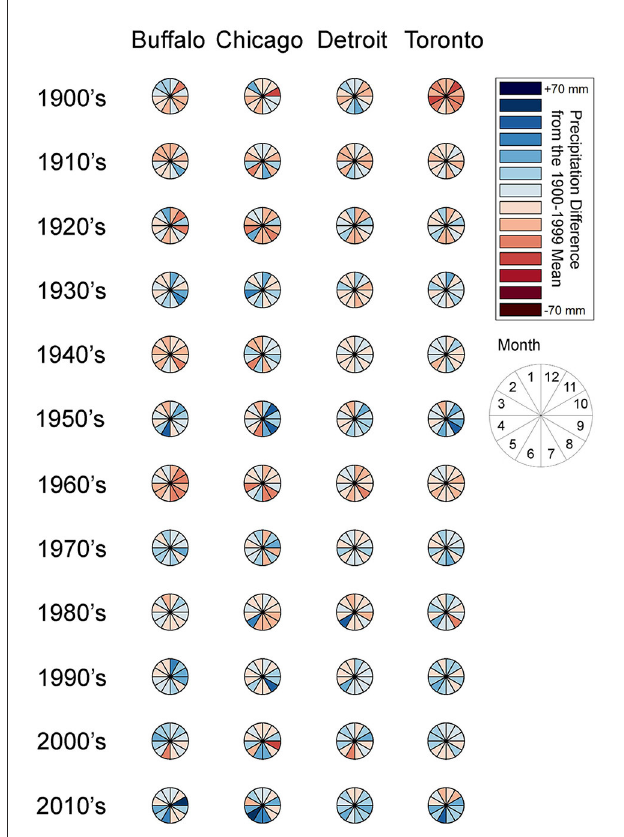
FIGURE6 Colorwheels of the 10-year mean monthly precipitation from the 120-year (1900–2019) mean for Buffalo, Chicago, Detroit, and